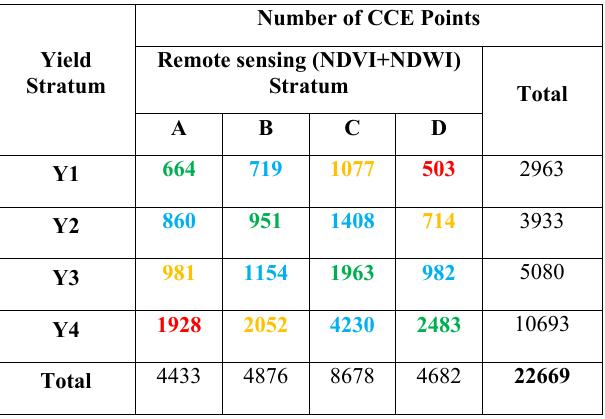
Table 3: Comparison of CCE points between yield and remote sensing stratum for the year